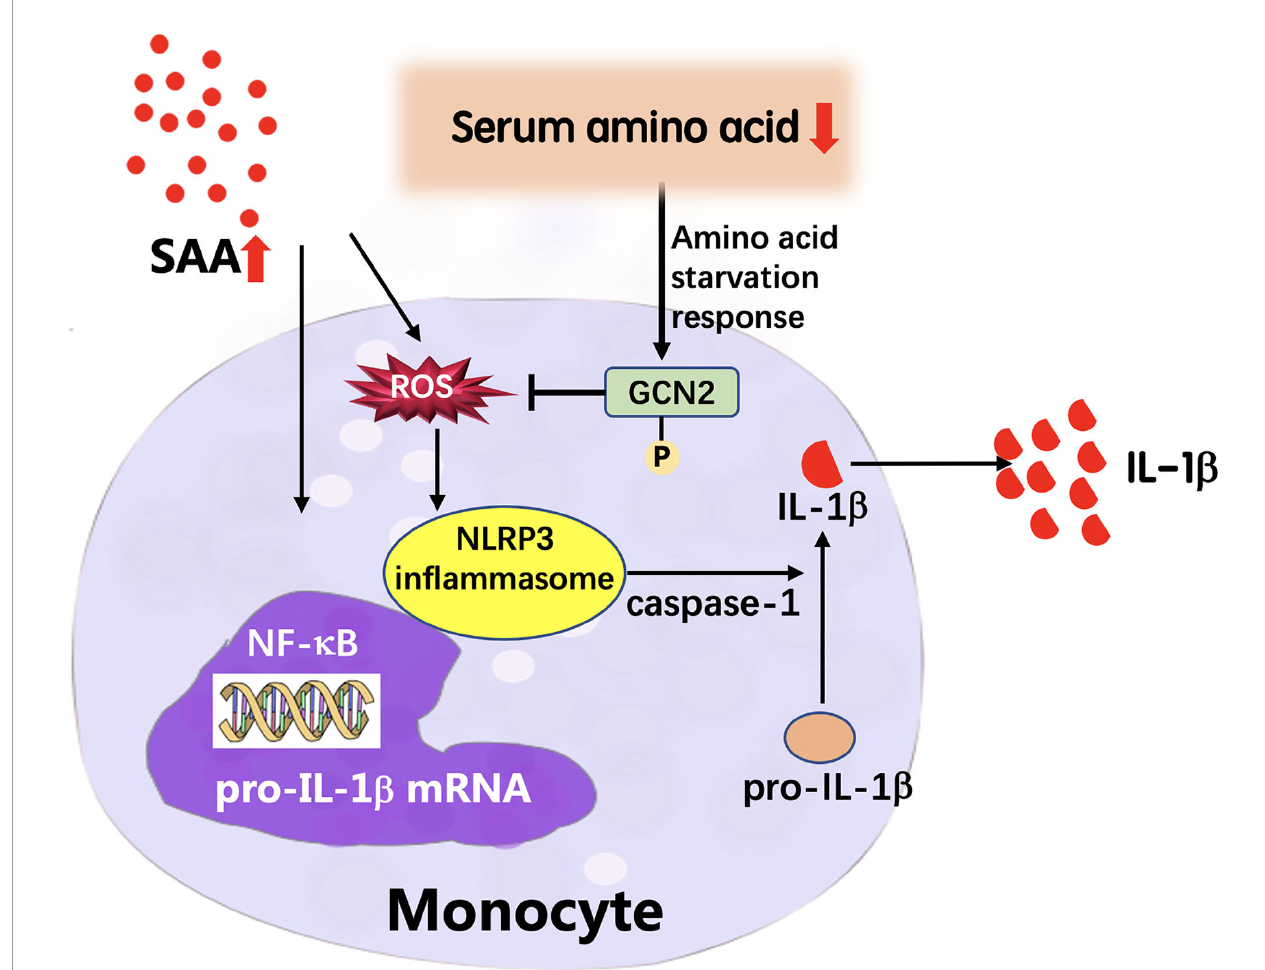
FIGURE 8 | Proposed model of the feedback mechanism by which low amino acids suppress IL-1 b expression in GPP. In GPP, IL-1 b and other in fl ammatory cytokines induce dramatic upregulation of acute-phase proteins including SAA. SAA activates the NLRP3 in fl ammasome pathway and secretion of mature IL-1 b from blood monocytes as an ampli fi cation loop; on the other hand, the acute-phase reaction results into amino acid starvation in circulation. Low amino acids induce activation of GCN2, which decreases ROS levels, thereby inhibiting NLRP3 in fl ammasome pathway and IL-1 b release, as a negative feedback